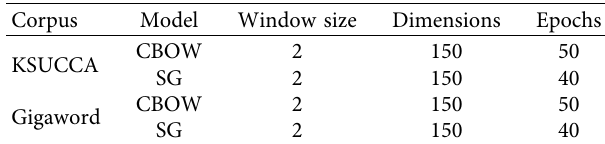
Table 10: Best hyperparameter values (window size, dimensions, and epochs) for word embeddings’ training with KSUCCA and Gigaword corpora on CBOW and SG models.